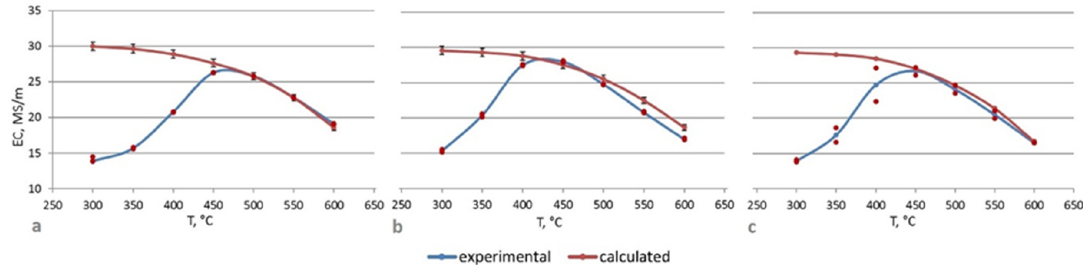
Figure 4. Calculated (according Equation (1)) and experimental values of electrical conductivity for cold rolled sheets of alloys ( a ) 1.5Mn, ( b ) 1.5MnCu and ( c ) 1.5MnCuZr.